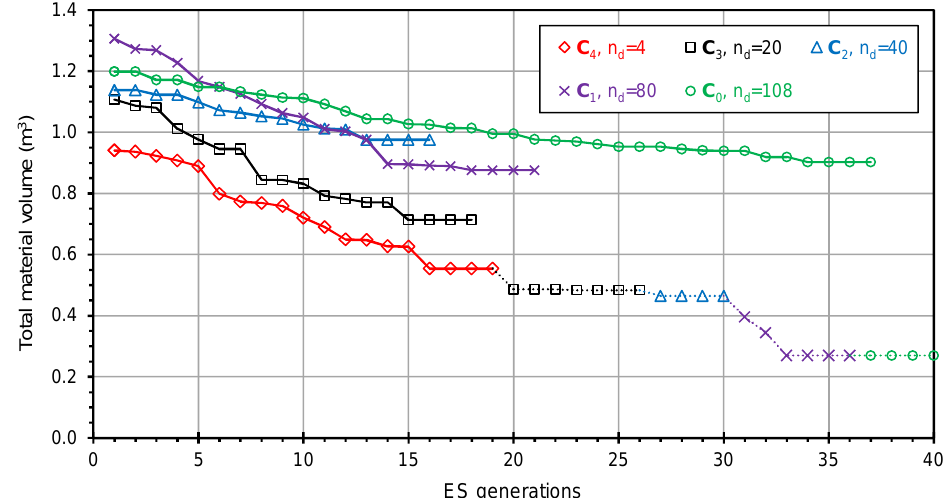
Figure 6. Test Problem 1 (wing box): convergence histories of non-cascade (solid lines) and cascade (dotted lines) optimization